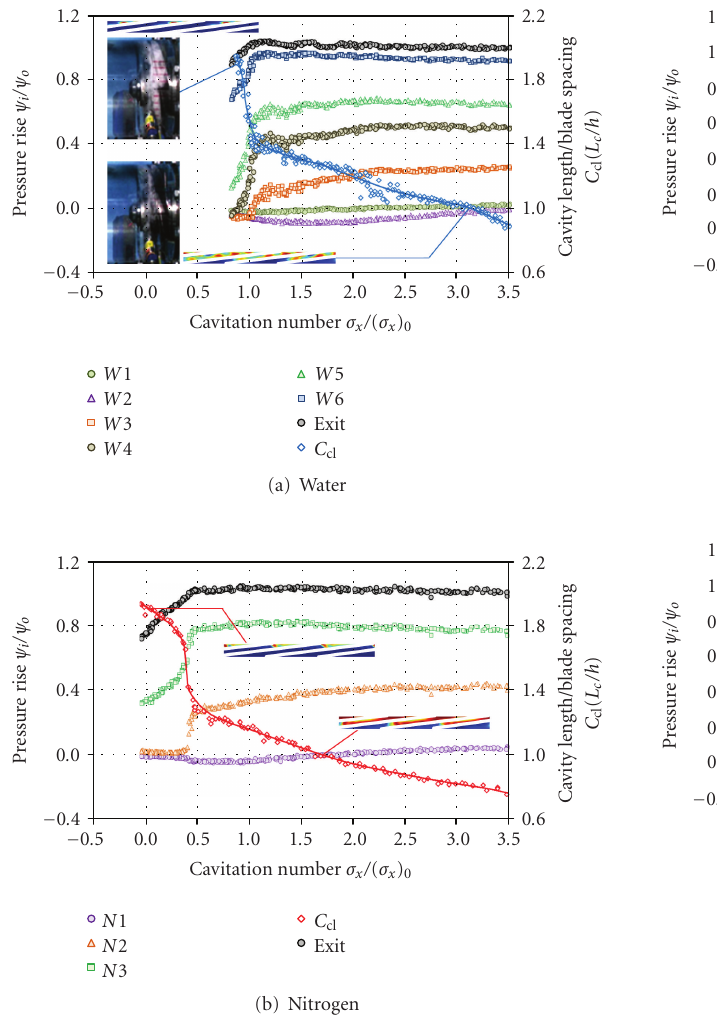
Figure 8: Pressure rise and cavity length in cold water (a) and in liquid nitrogen (b).